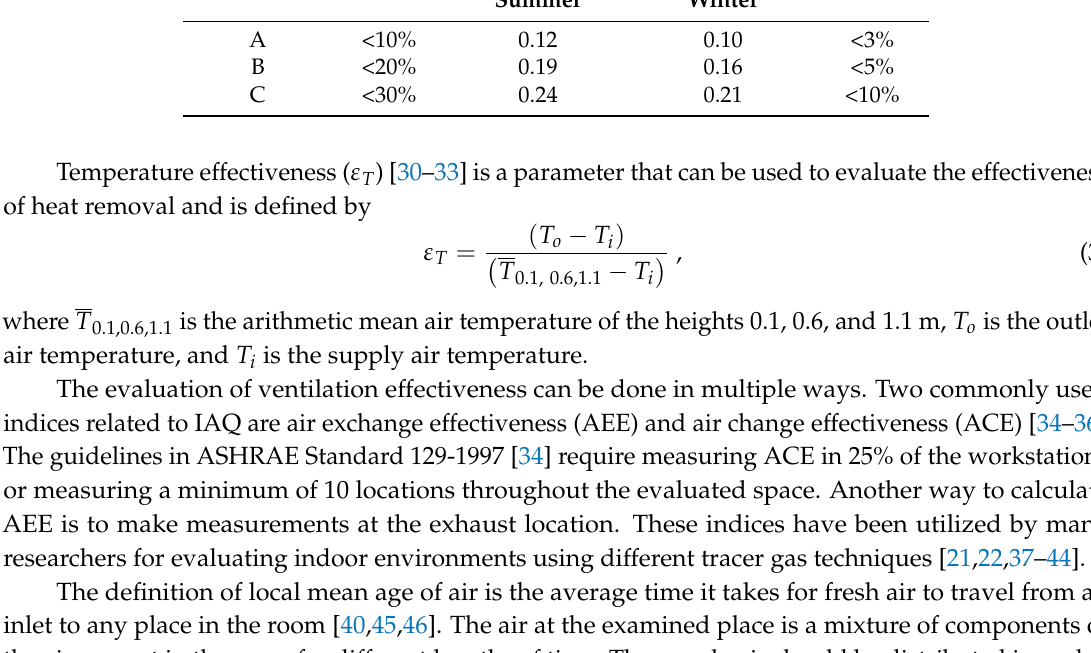
Table 1. Local thermal comfort category based on ISO 7730. DR: draught rate PD: percentage dissatisfied.